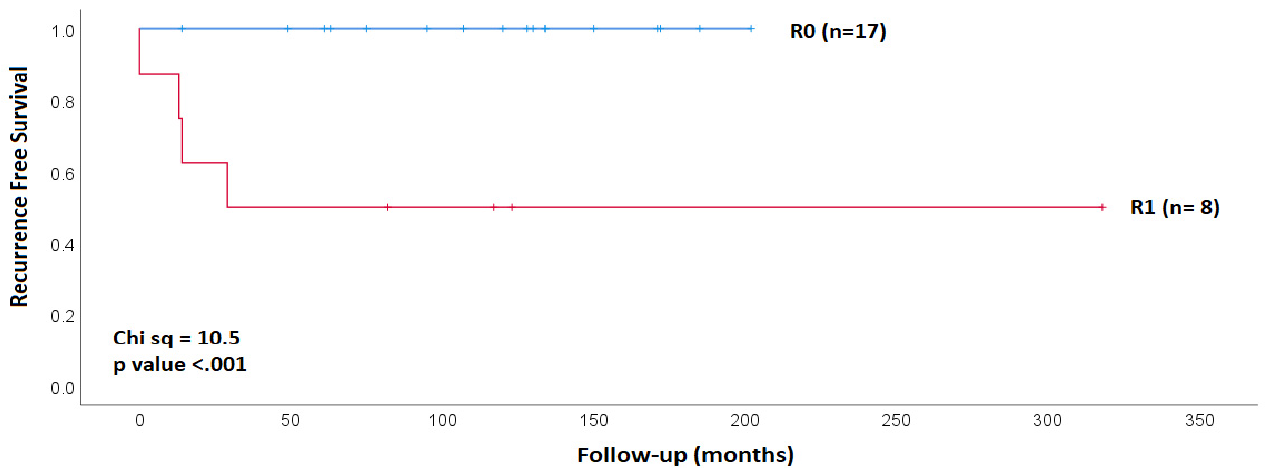
Figure 1. Kaplan–Meier plot of recurrence free survival (RFS) according to margin status following initial surgery. RFS was 100% in patients with R0 resection and 50% in patients with R1 resection.